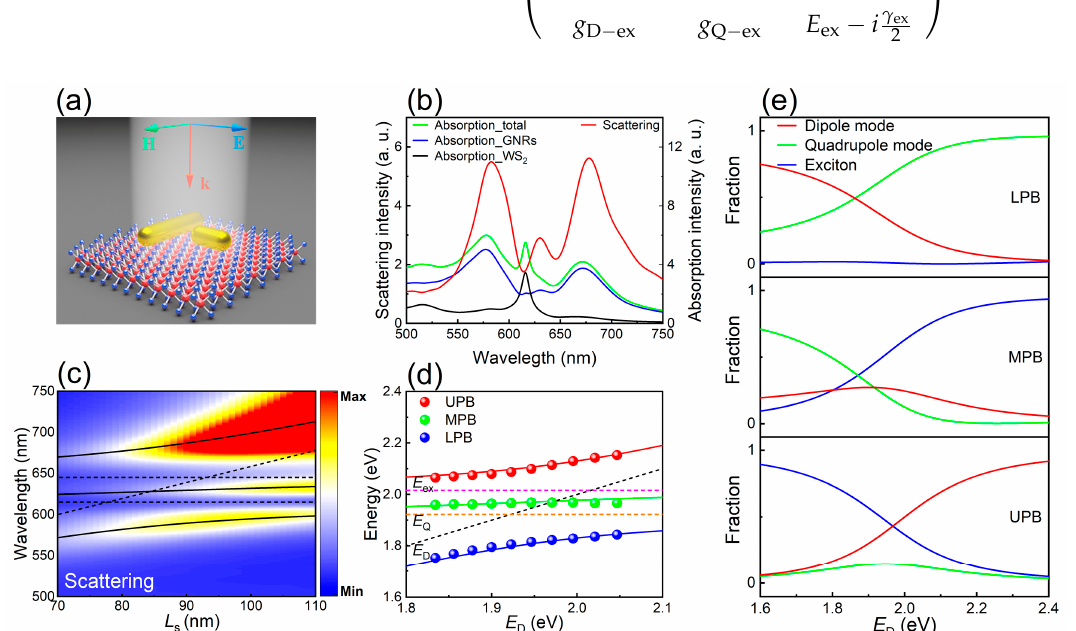
Figure 5. Strong dipole–quadrupole–exciton coupling realized in a T-shaped GNR dimer placed on a monolayer WS 2 . ( a ) Schematic showing a T-shaped GNR dimer placed on a monolayer WS 2 and excited by a plane wave. ( b ) Scattering spectrum calculated for the GNR dimer placed on a WS 2 monolayer with L l = 248 nm, L s = 81 nm and w = 10 nm. The absorption spectra of the long and short GNRs only and the absorption spectrum of the monolayer WS 2 are also provided. ( c ) Two-dimensional scattering spectra calculated for GNR dimers composed of short GNRs with different lengths. ( d ) The red, green and blue circles represent the upper, middle and lower polariton branch (UPB, MPB and LPB) resonance energies extracted from the scattering spectrum of T-shaped GNR dimer placed on a WS 2 monolayer hybrid structure. The red, green and blue solid lines represent the resonance energies of UPB, MPB and LPB fitted by Hamiltonian analysis Equation (3). The black, orange and pink dashed lines represent dipole, quadrupole and exciton resonances, respectively. ( e ) Hopfield coefficients for dipole, quadrupole and exciton modes contributions to UPB, MPB and LPB as a function of dipole resonance.